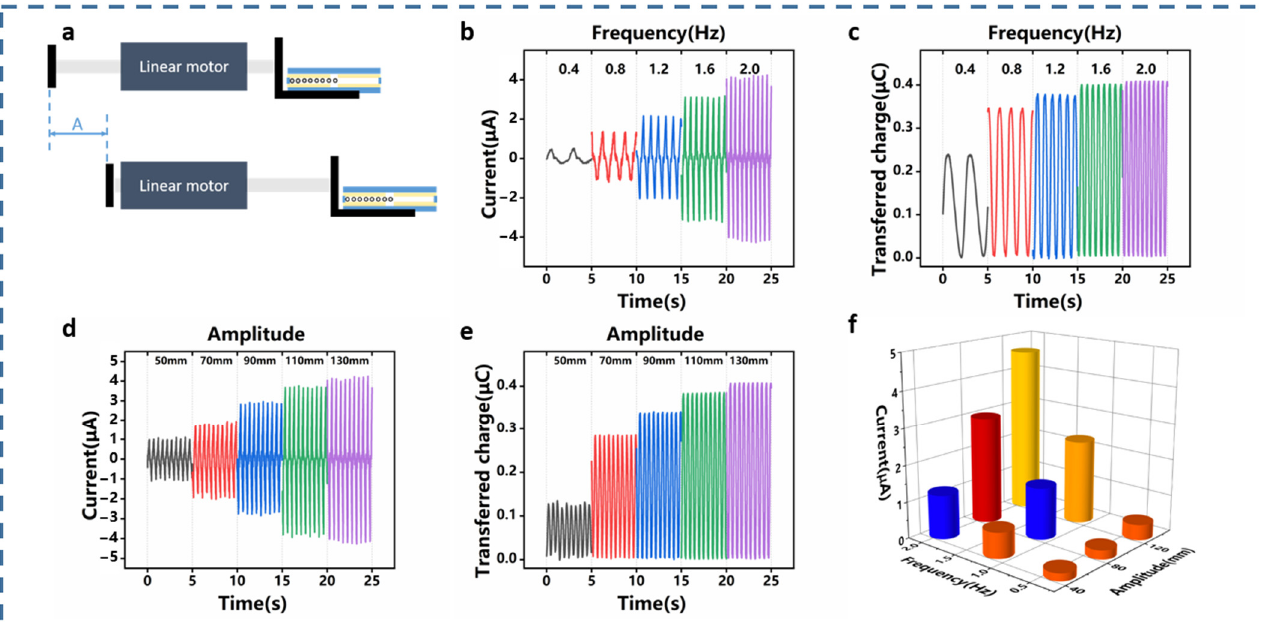
Figure 3. ( a ) Experimental schematic diagram of the MT-TENG. The short circuit current I sc ( b ) and short circuit transferred charge Q sc ( c ) measured under different frequencies with the amplitude of 130 mm. The short circuit current I sc ( d ) and transferred charge Q sc ( e ) measured under different amplitude at the constant frequency of 2 Hz. ( f ) A 3D graph of the short circuit current I sc peak value at different frequencies and amplitudes.